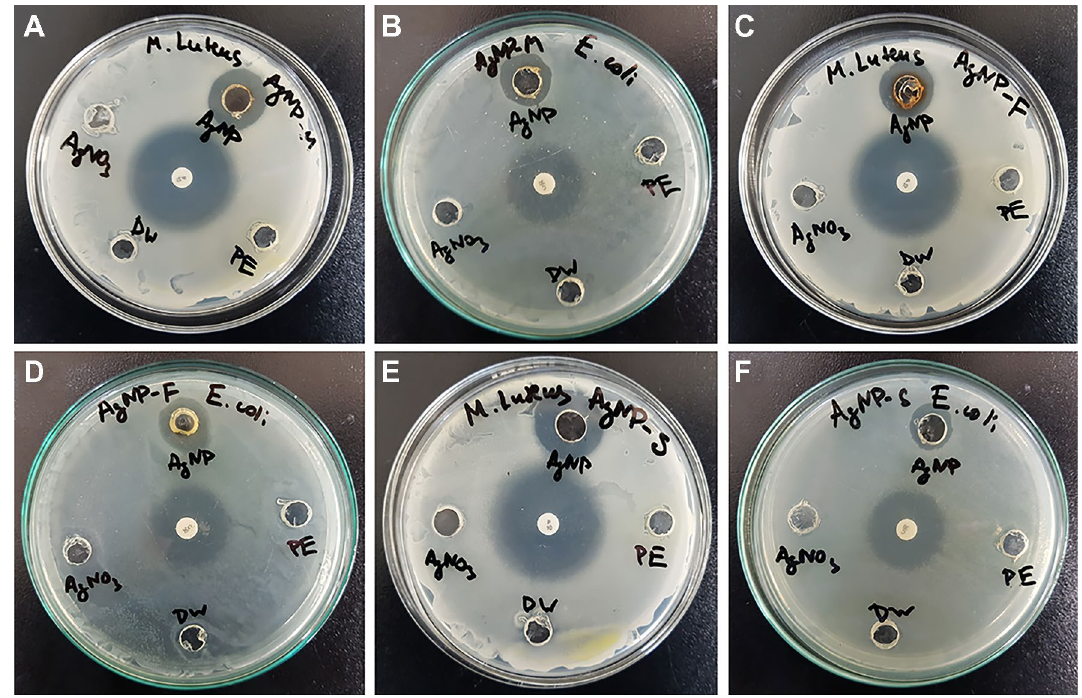
Figure 9. Petri dishes showing the zone of inhibition of synthesized AgNP-W on ( A ) M. luteus and ( B ) E. coli , and AgNP-F on ( C ) M. luteus and ( D ) E. coli , AgNP-S on ( E ) M. luteus and ( F ) E. coli (AgNP: silver